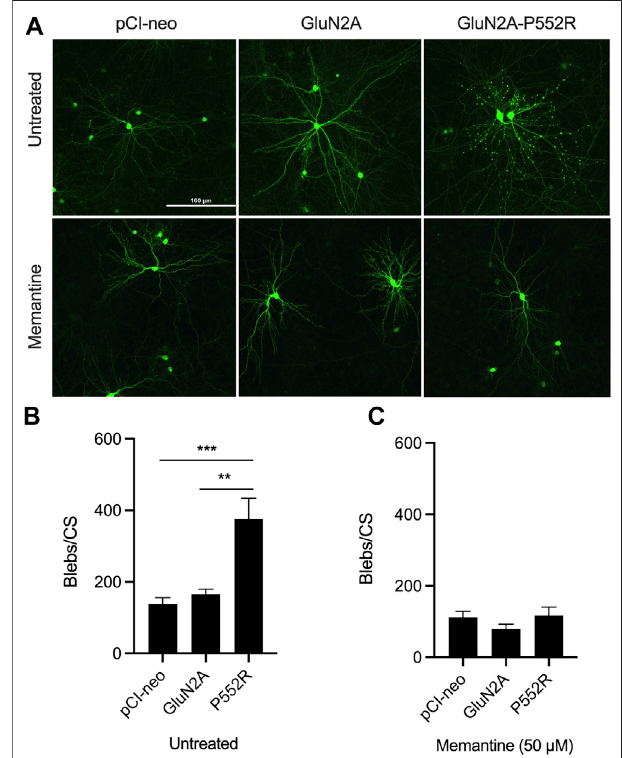
FIGURE 1 | GluN2A-P552R expression exerts dendrotoxicity in rat primary cortical cultures which can be rescued by treatment with memantine. Representative images of cortical neurons transfected with GFP and either pCI-neo (empty vector), GluN2A, or GluN2A-P552R. Top row shows untreated neurons and bottom row shows neurons co-treated with 50 µM memantine (A) . Quanti fi cation of dendritic blebs per coverslip (blebs/CS) revealed signi fi cantly more blebs in GluN2A-P552R transfected neurons as compared to those transfected with pCI-neo or GluN2A (B) . This difference is abolished by treatment with 50 µM memantine (C) . Data are expressed as mean ± SEM from three independent experiments with three coverslips per transfection condition in each experiment (** p < 0.01, *** p < 0.001, one-way ANOVA/Tukey post-hoc, n (cid:2)